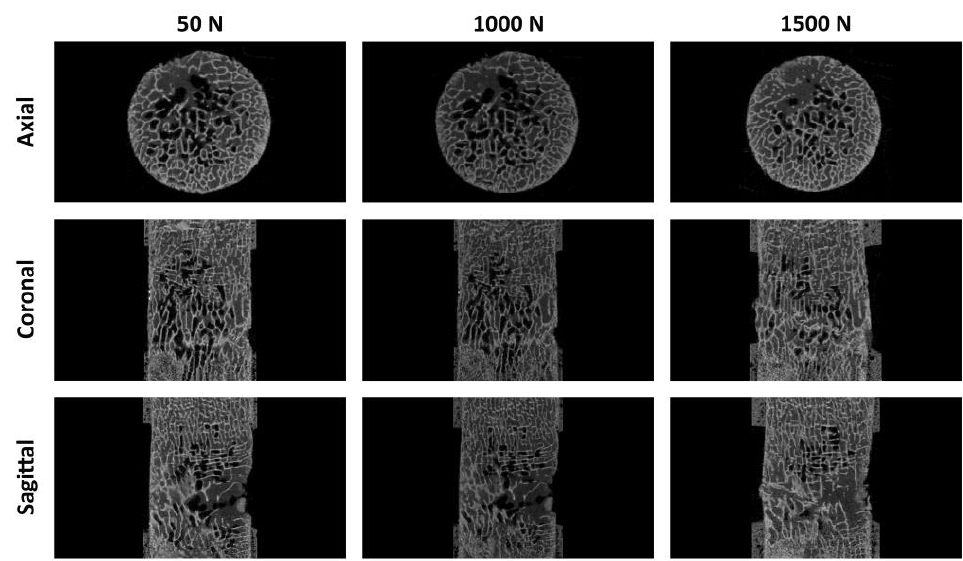
Figure 6. Axial, coronal and sagittal images of Bos taurus L2 sample 50 N and 1000 N, 50 N and 1500 N). The bone structure of the bovine specimens fractured at 1000 N and 1500 N.